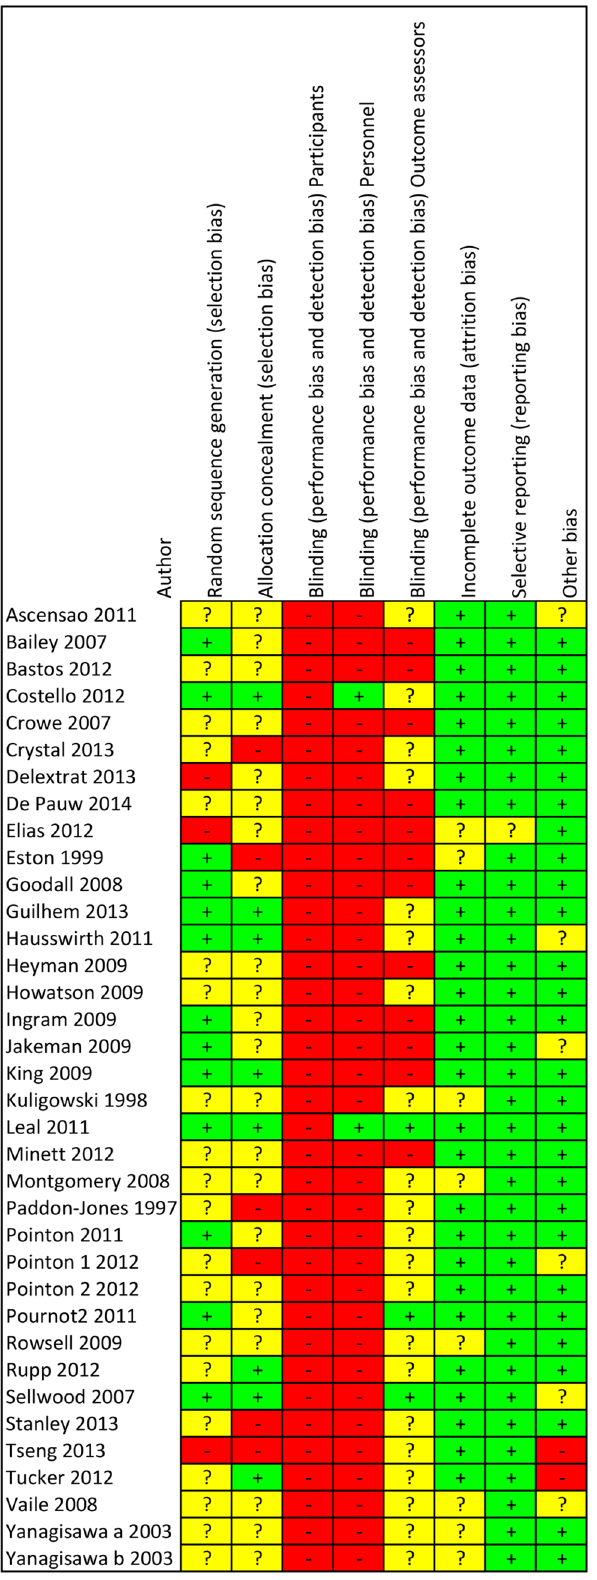
Fig 2. Risk of bias graph for each included study.